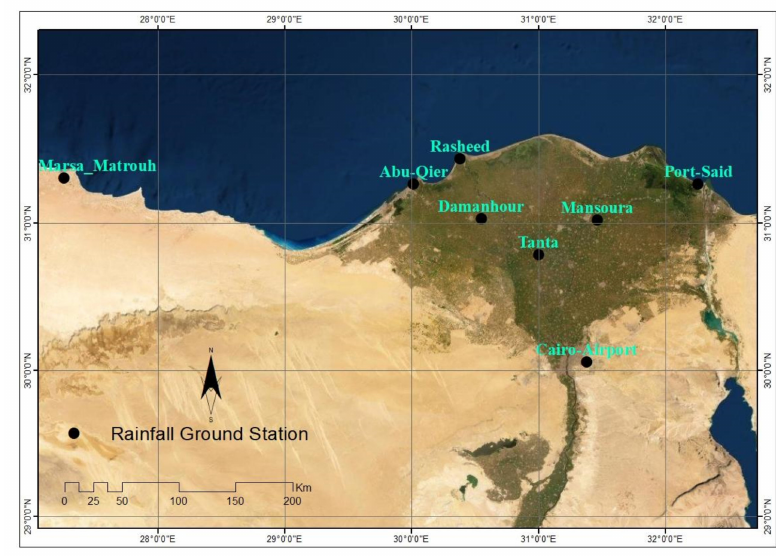
Figure 1. Locations of used ground